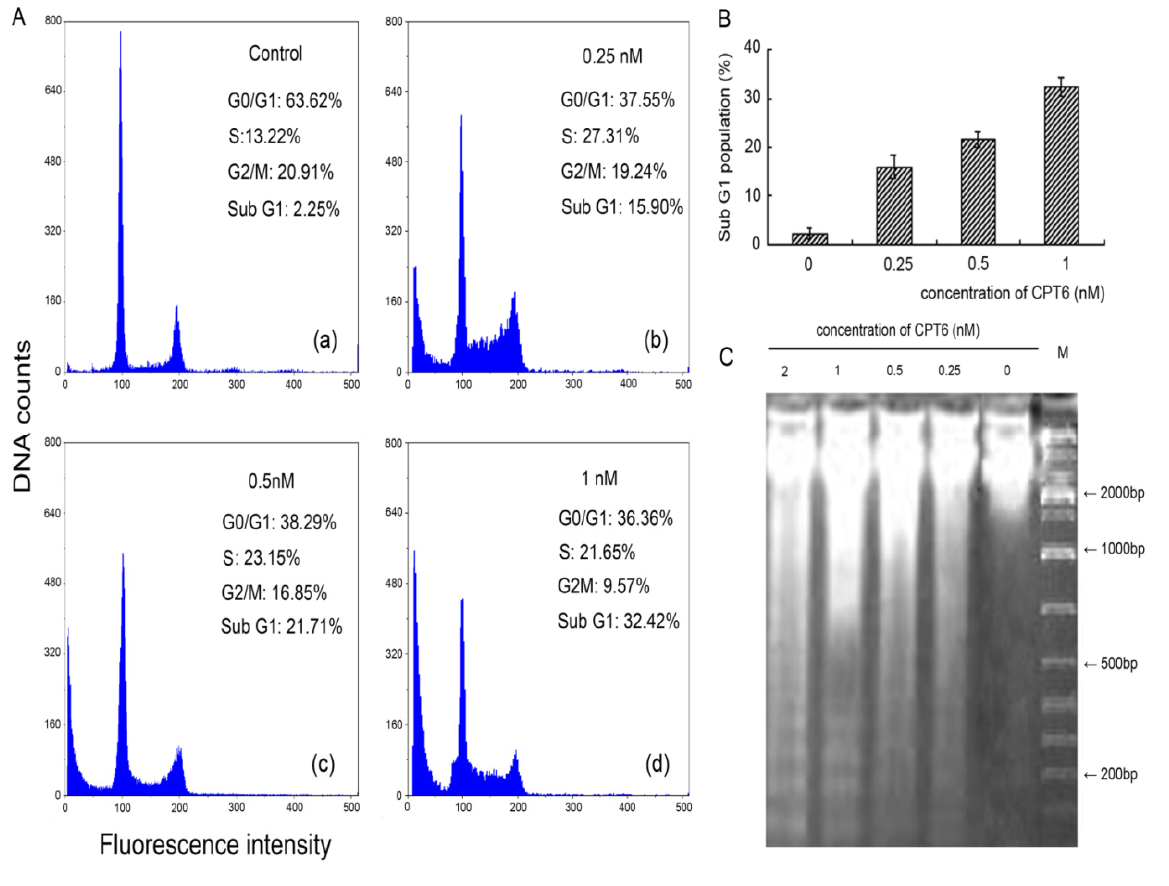
Figure 3. CPT6 induces apoptosis in MCF-7 cells at 48 h. A : Flow cytometric analysis of MCF-7 cell cycle distribution (excitation wavelength: 351 nm; emission wavelength: 380 nm). ( a ) Control group; ( b ) treatment with 0.25 nM CPT6; ( c ) treatment with 0.5 nM CPT6; ( d ) treatment with 1 nM CPT6. B : The proportional (%) of Sub-G1 phase population. C : DNA fragmentation of apoptotic MCF-7 cells treated with CPT6 at 0, 0.25, 0.5, 1 and 2 nM for 48